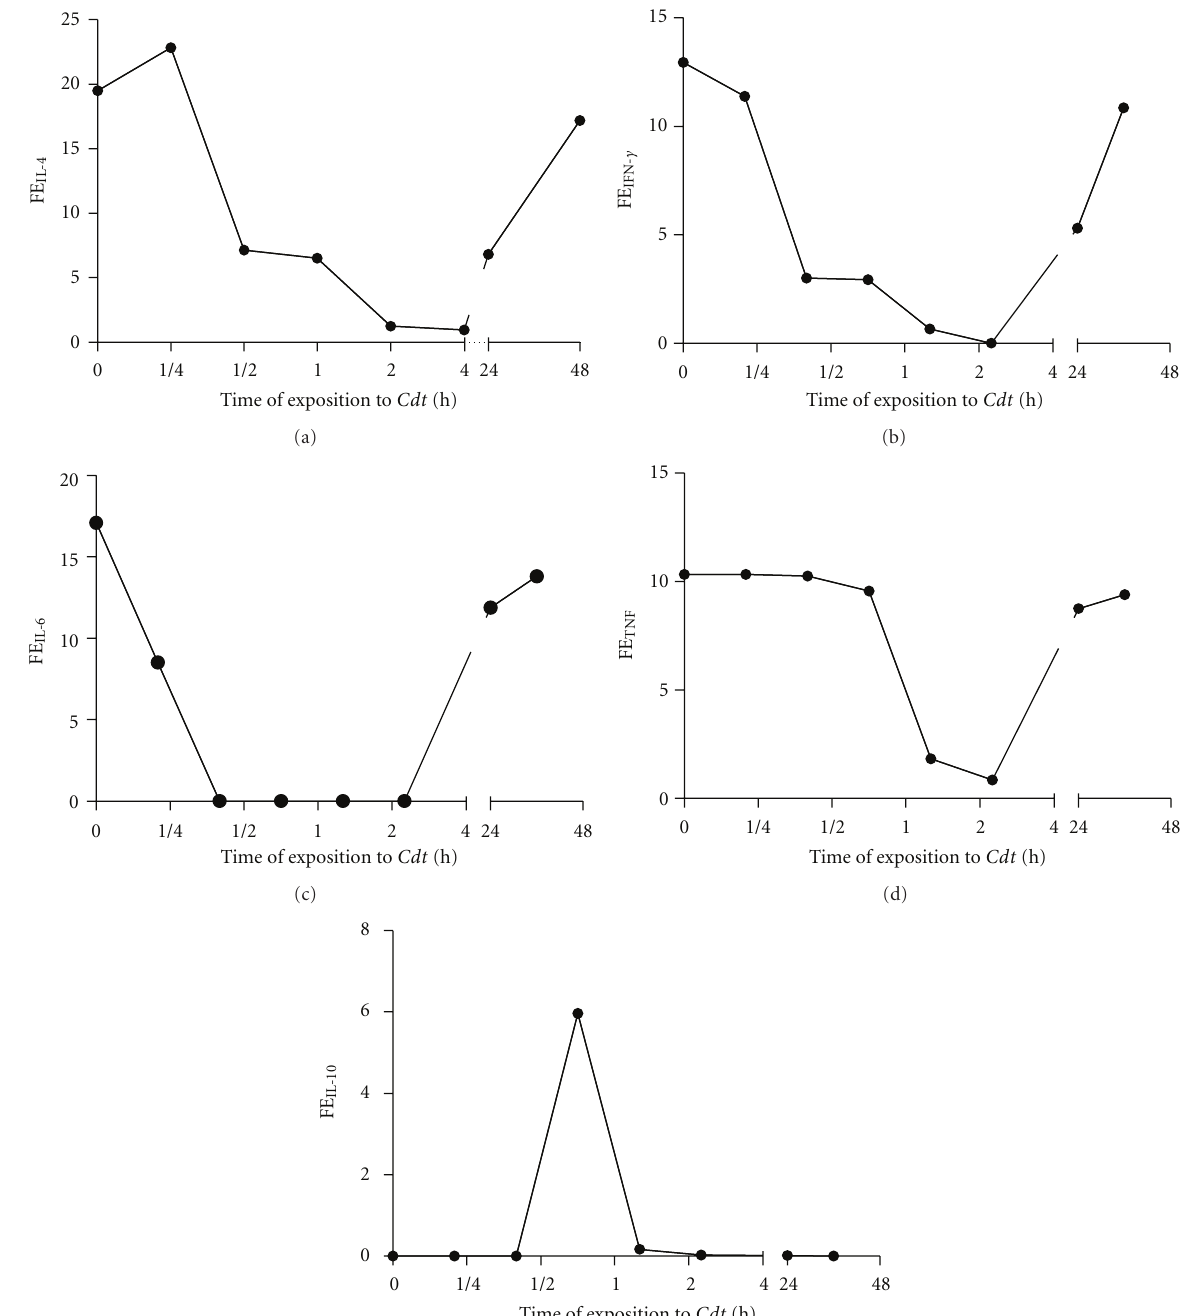
Figure 5: Percentage of fractional excretion of cytokines. Groups of BALB/c female mice were injected i.p. with 1 LD 50 of Cdt for di ff erent times as above described. The percentage of fractional excretion was determined as described in Section 2. Each point represents the mean value of samples from four experiments in di ff erent groups of five mice. Statistical di ff erences between the treatments were ( P > 0 . 01).